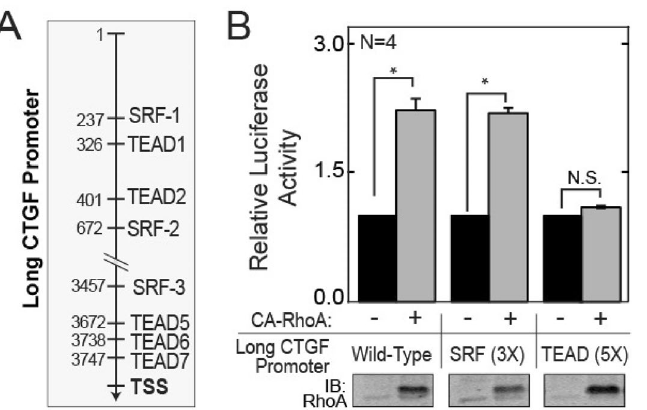
Figure 2. Induction of CTGF expression by RhoA Requires TEAD but not SRF elements. ( A ) Depiction of the SRF and TEAD elements in the long (~ 3.9 kb) CTGF promoter. ( B ) Fold-change in relative luciferase activity in lysates from MCF7 cells transfected with a PGL3.1 reporter containing the indicated variants of the 4 kb (long) promoter of CTGF in combination with Thymidine Kinase (TK)-Renilla and either a control plasmid or a plasmid expressing the constitutively active (CA)-RhoA (Q63L)